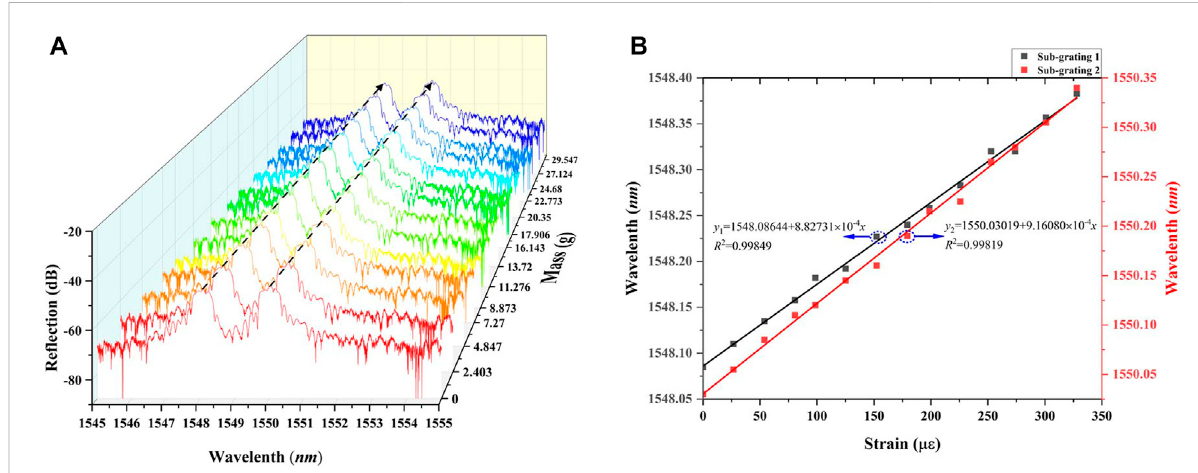
FIGURE 6 Results of the strain sensing experiment at room temperature (25 ° C ). (A) Re fl ection spectra of 2D FBG at different strain. (B) The center wavelength and linear curve fi tting results of the two sub-gratings of 2D FBG at different strain.